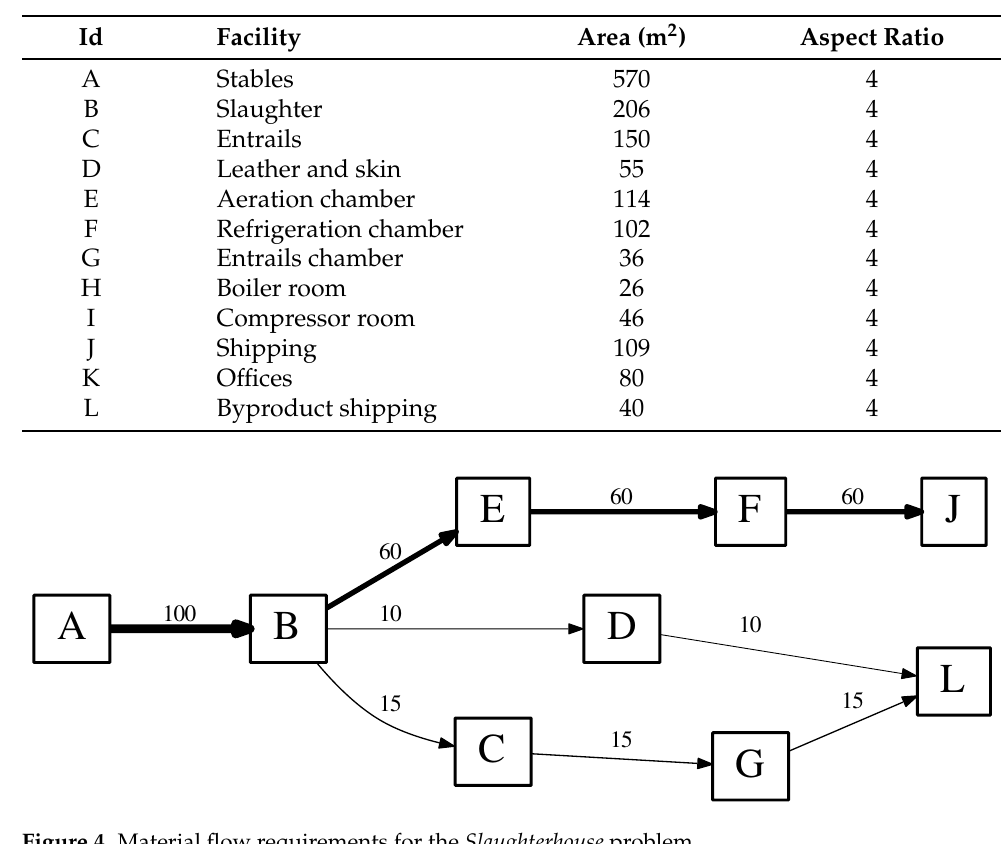
Figure 4. Material flow requirements for the Slaughterhouse problem. Table 3. DMs’ particular preferences for Slaughterhouse